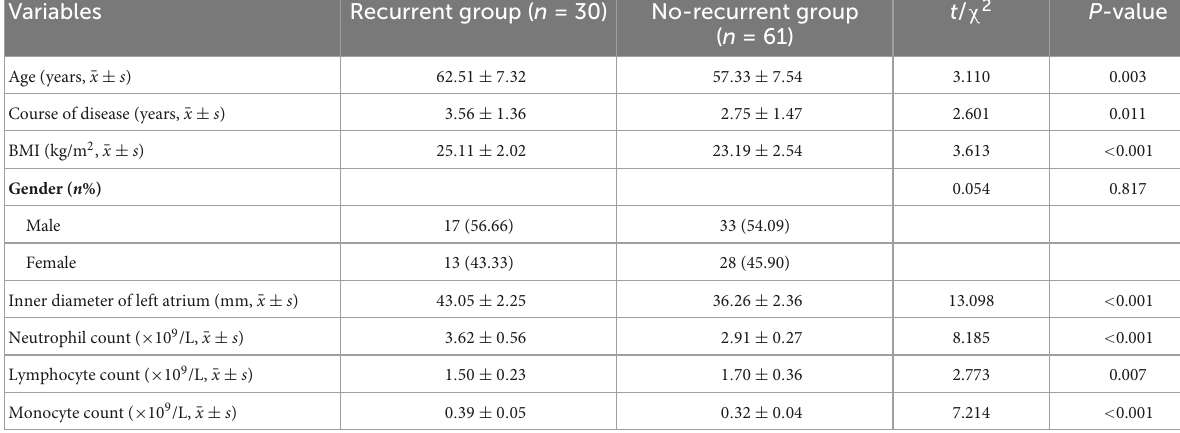
TABLE 1 The comparison of baseline information between two groups.